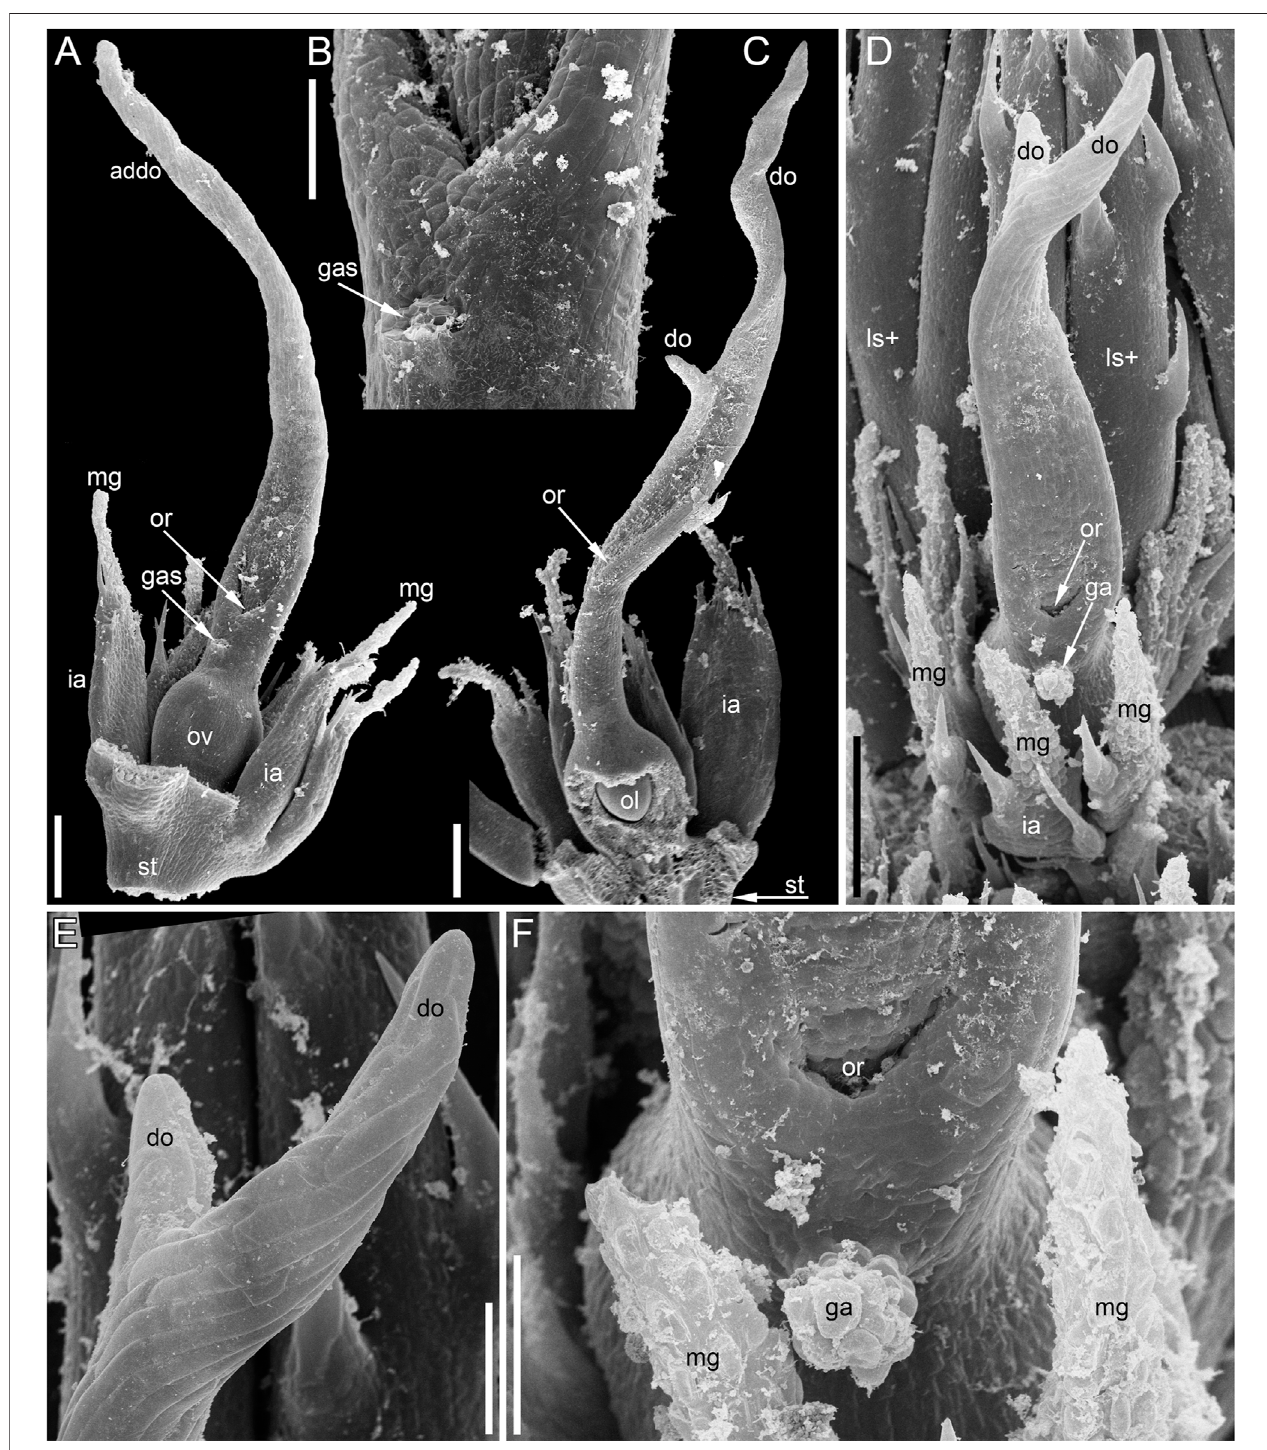
FIGURE 4 | Pistillate fl owers of Ceratophyllum demersum (SEM). (A) Abaxial view of fl ower with single, unlobed distal gynoecial outgrowth. Some involucral appendagesare removedtoshow theovary.Theglandularappendage ofthe gynoecium isabscised,but its scarisvisible. (B) Detail of (A) showing thegynoecialori fi ce and a scar of the ascised glandular appendage. (C) Dissected fl ower with unequally bilobed distal gynoecial outgrowth. The ovary is unilocular, with a single pendent ovule. (D) Abaxial view of fl ower with bilobed distal gynoecial outgrowth. (E) Detail of (D) showing the two lobes of the distal outgrowth. (F) Detail of (D) showing glandular gynoecial appendage. Scale bars = 300 μ m in (A,C,D) , 100 μ m in (B,E,F) .